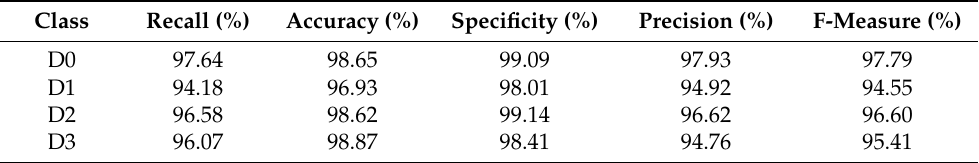
Table 5. Evaluation of the performance of the ANN-ICA classifier at 200 repetitions, using the criteria derived from the confusion